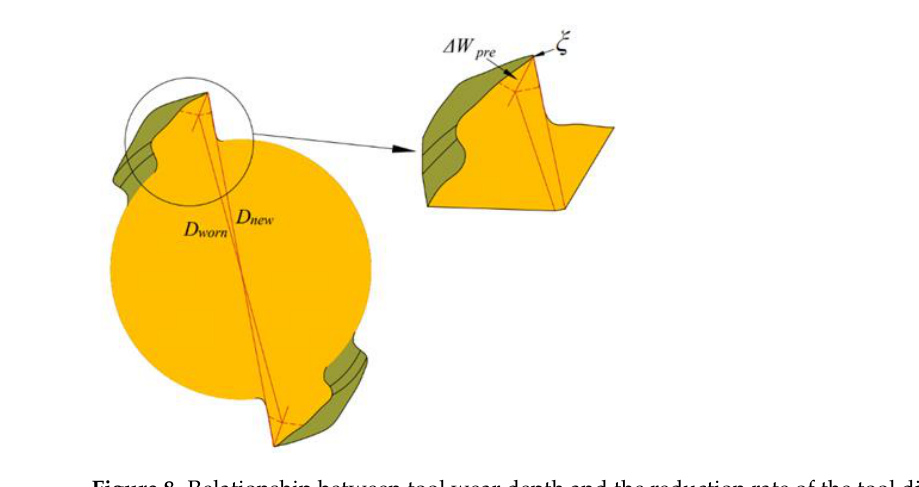
Figure 8. Relationship between tool wear depth and the reduction rate of the tool diameter.